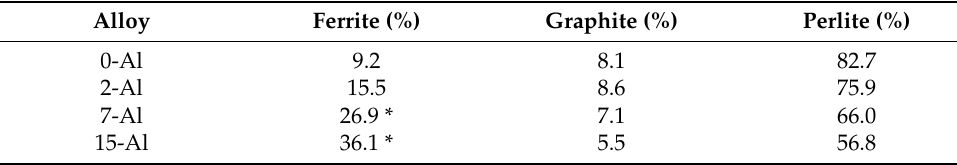
Table 3. Phase volume fraction of the studied alloys.